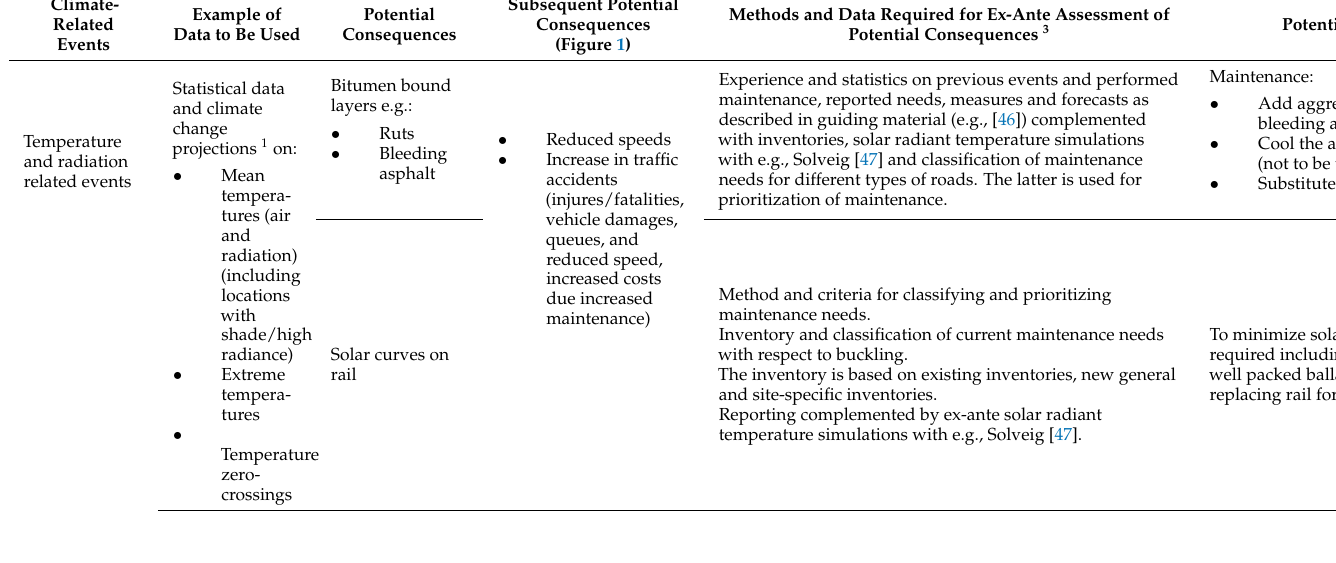
Improvements Needed for More Robust Effect